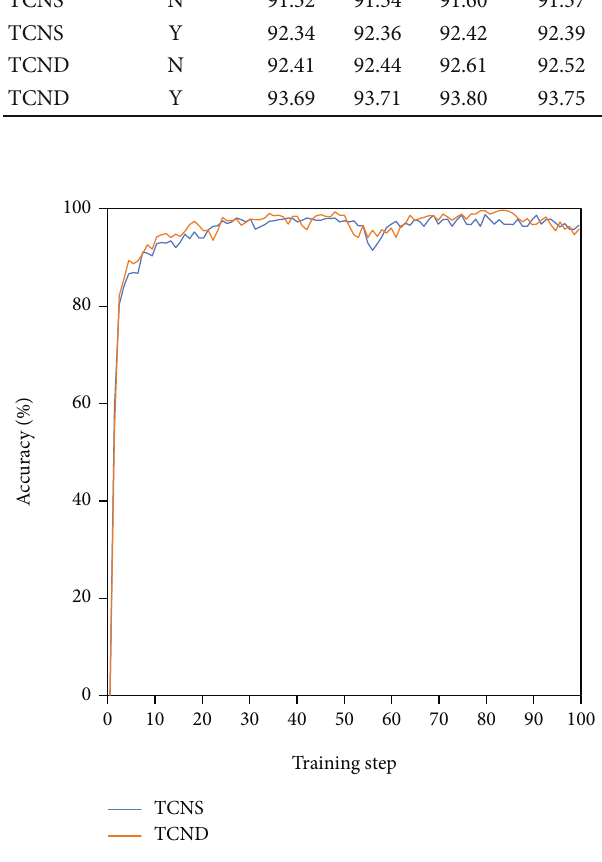
Figure 10: Accuracy curves of the network training set for the proposed two TCN